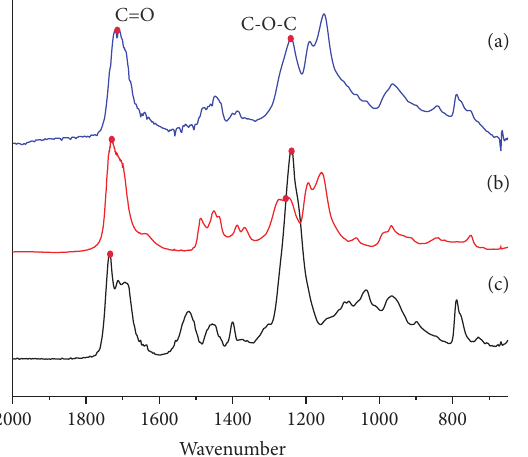
Figure4:FTIRspectraoftheP(MMA-co-MAA)coatedPUfilm(a), the 2% P(MMA-co-MAA) film (b), and the porous PU film (after PEG extraction) (c).